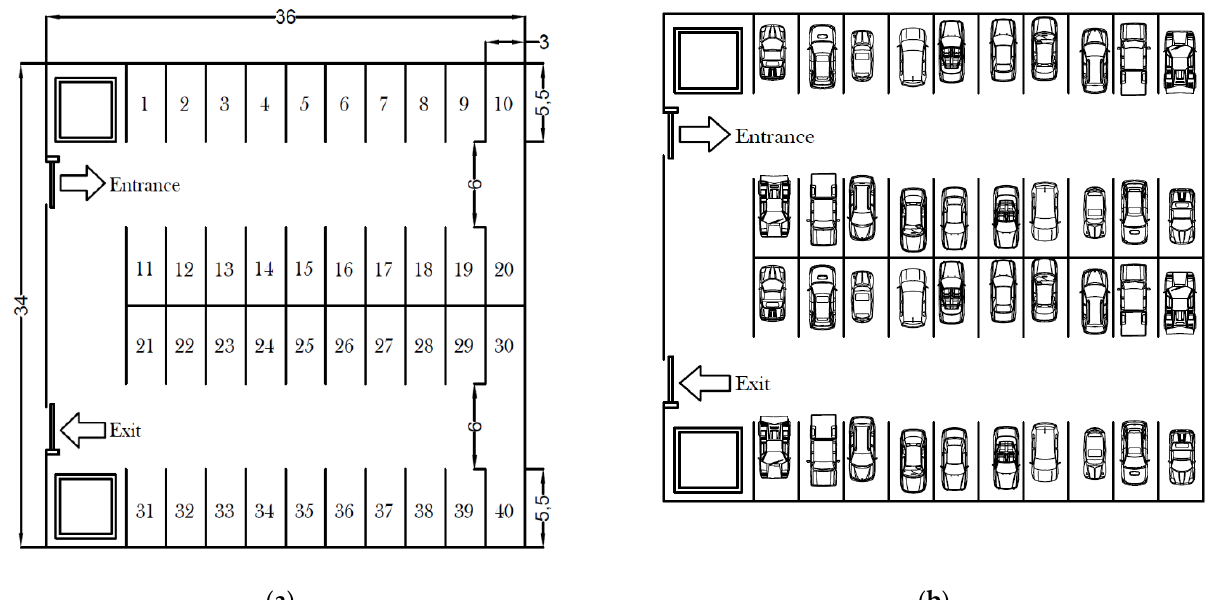
Figure 1. Example of a typical electric vehicle parking lot in Montreal, Canada. ( a ) EVPL with dimensions, ( b ) EVPL with dimensions.